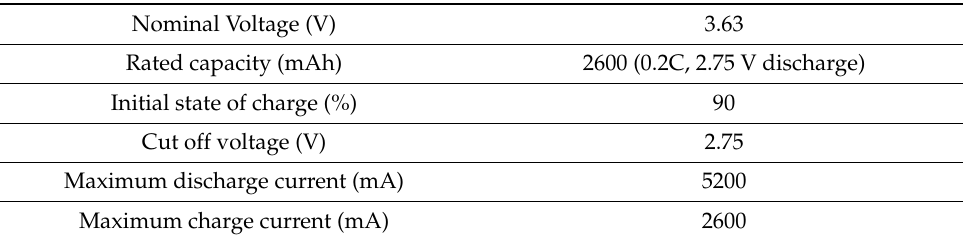
Table 3. Battery